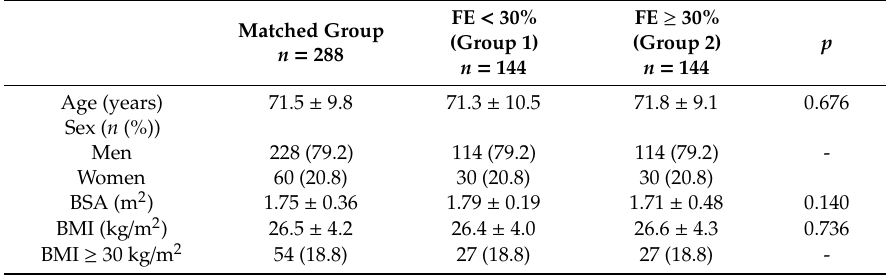
Table 2. Baseline characteristics of propensity score matched group and among both groups according to the